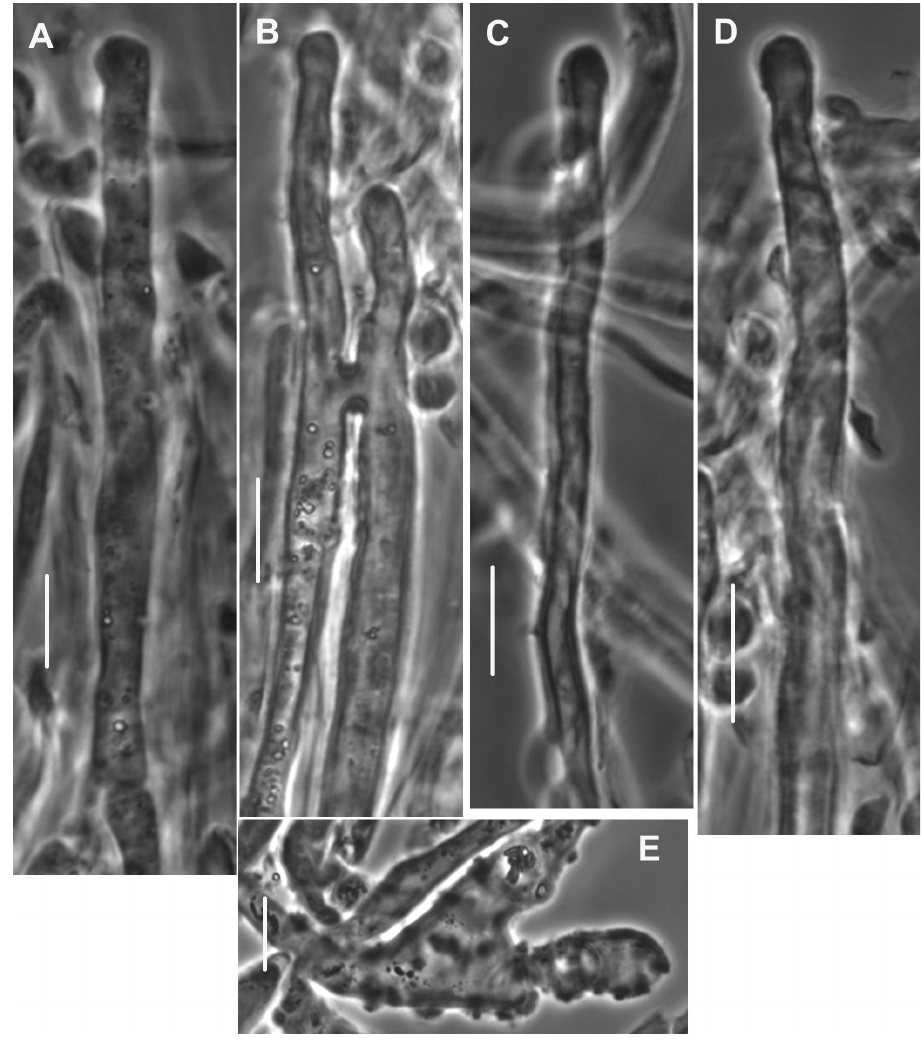
Figure 33. Mycetinis curraniae . A–D Repent caulocystidia E Strongly encrusted pileipellis hypha. Standard bars = 10 µm. ZT 949